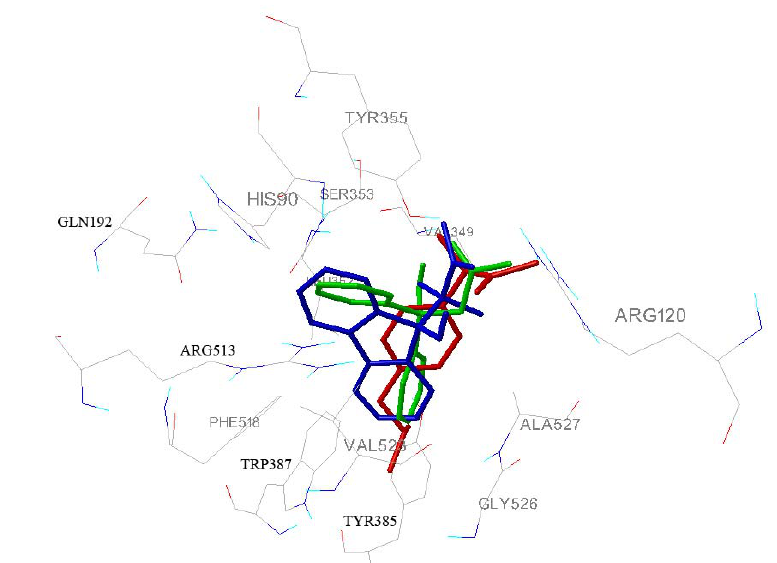
Figure 4 . Superimposition of most favourable conformations of compounds 3 (green), 5 (blue), and ibuprofen (red) docked into binding site of COX-2 receptor. This image was created using AutoDockTools 1.4.5.